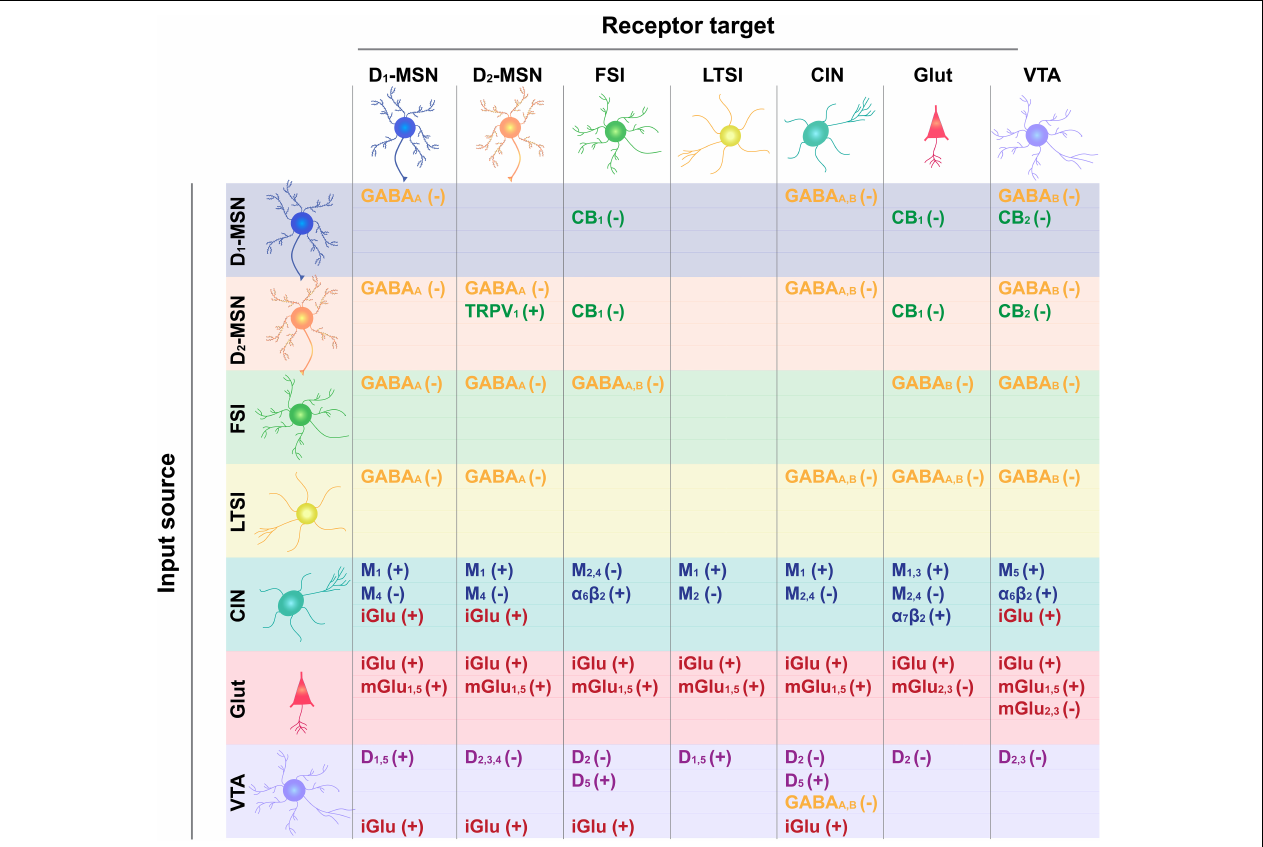
FIGURE 2 | Receptor target for neurotransmitter input-output connections depicted in Figure 1 . Input cell type is shown on the left and output target on the top. GABA type A and B receptor targets are shown in yellow, cannabinoid type 1 (CB1) and 2 (CB2) receptor targets are in green, glutamate ionotropic (iGluR) and metabotropic (type 2,3: mGluR 2 , 3 ; type 1,5 mGluR 1 , 5 ) are in red, acetylcholine muscarinic receptor subtypes (M 1 ; M 2 ; M 4 ; M 1 , 3 ; M 2 , 4 ; M 5 ) and ionotropic receptor subtypes (alpha 6 Beta 2, α 6 β 2 and α 2 β 2 ) are in blue, and DA receptor subtypes (D 1 -type: D 1 , D 5 , D 1 / 5 ; D 2 -type: D 2 , D 2 / 3 , D 2 / 3 / 4 ) are in purple. How receptor binding influences cell excitability is indicated by a positive (+) or negative (–)